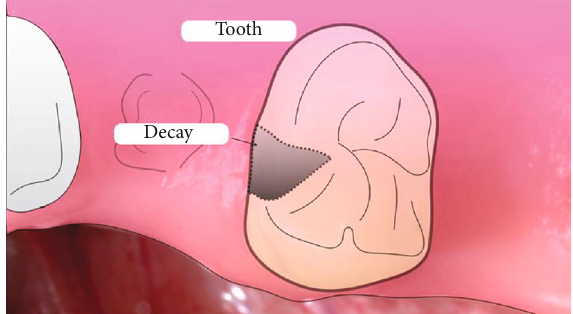
Figure 3: Iconographic representation of the tooth decay on the interproximal